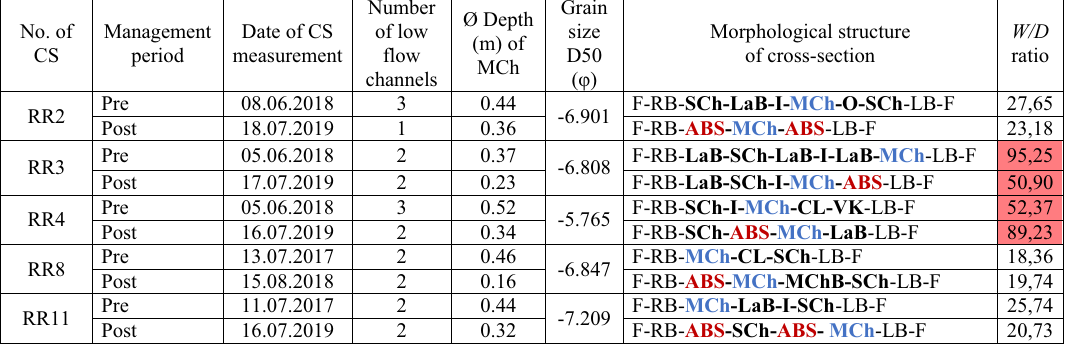
Table 1. Selected morphological parameters (number of low flow channels, depth of main channel), morphologic structure (in the right to left order) and W/D ratio of monitored cross-sections on river reaches where the river training was realized (Pre: before the flood event in July 2018; Post: after the flood event in July 2018 and management intervention). Median grain size (D50) of the sediment material was measured on gravel bars as well as under the water on the main and secondary channels based on Wolman 43 approach. CS cross- section, RR river reach, F floodplain, RB right bank, LB left bank, MCh main channel, SCh secondary channel, LaB lateral bar, MChB mid-channel bar, I island, ABS artificial bar